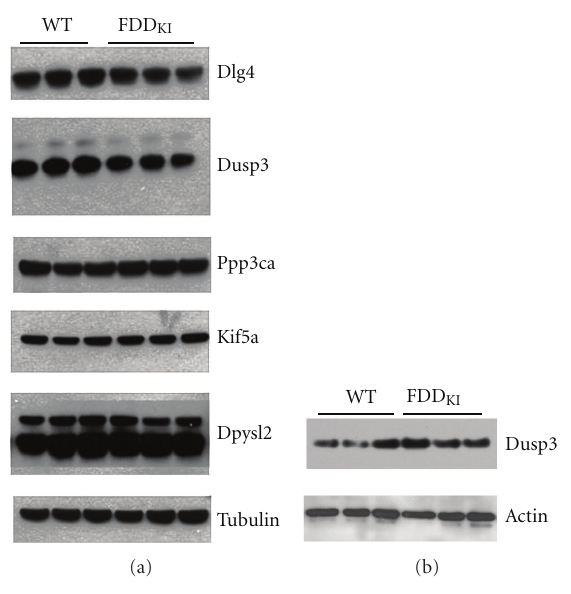
Figure 3: Validation of the 2D-DIGE results by western blot analy- sis. (a) Triplicate synaptosomal preparations from wild-type and FDD KI mouse synaptosomes were separated on SDS-PAGE gels and transferred to membranes for western blot analysis with antibodies against the indicated proteins. Actual downregulation in the synap- tosomal samples of FDD KI mice can be observed for Dlg4/Psd95 and Dusp3 proteins. α -Tubulin antibody was used to show equal loading of the protein extracts. (b) Total brain homogenates from wild-type and FDD KI mice were analyzed by western blot with antibodies against Dusp3. Actin antibody was used to show equal loading of the protein